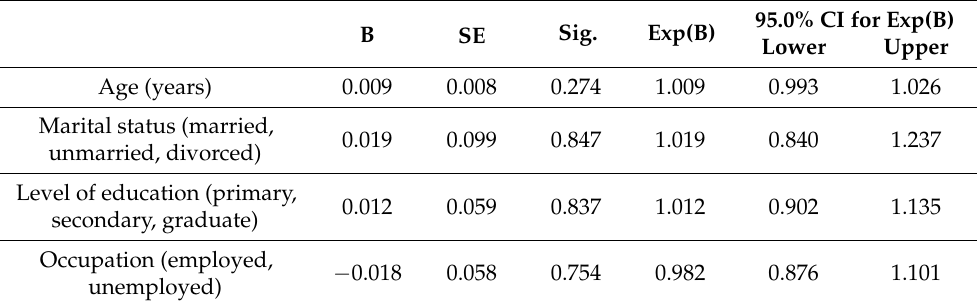
Table 5. The Cox proportional hazards analysis of the relationship between physical activity and other prognostic variables and diagnosis of abdominal obesity (WC => 80 cm) in female subjects at follow